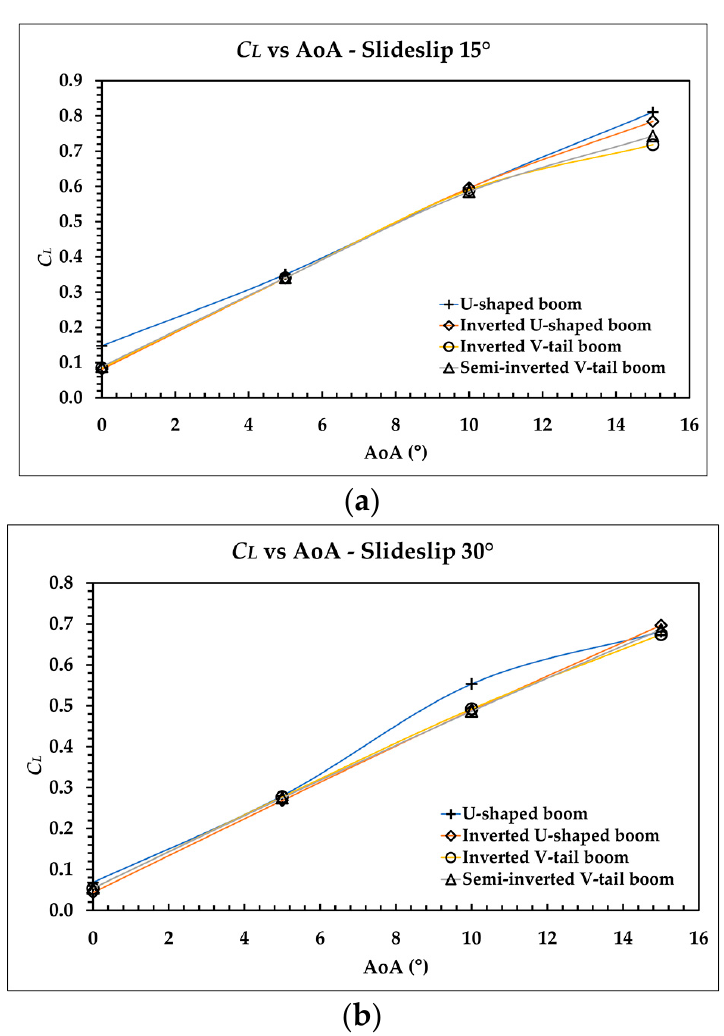
Figure 11. Coefficient of lift vs. AoA, sideslip angle: ( a ) 15° and ( b ) 30°.